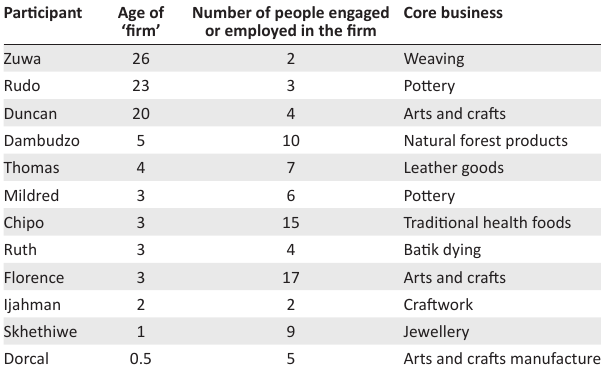
TABLE 1: Summary sample